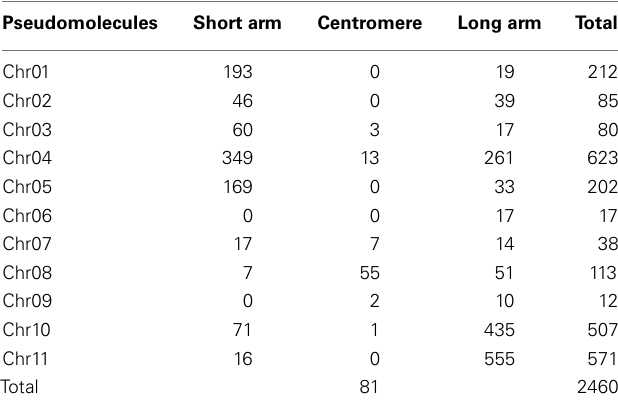
Table 1 | Number of complete khipu units in each pseudomolecule of Phaseolus vulgaris